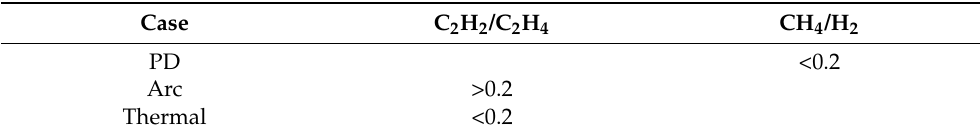
Figure 3. Output membership functions.